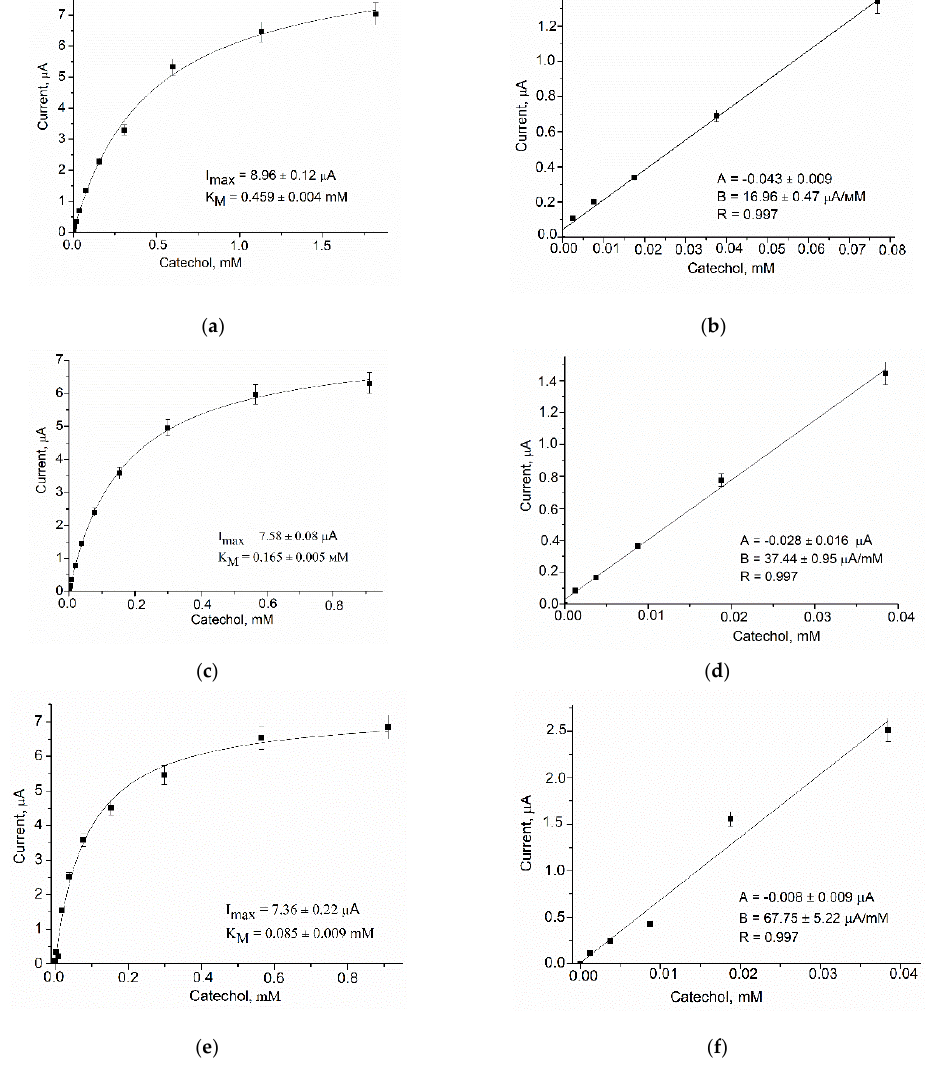
Figure 8. Amperometric characteristics of the laccase/GE ( a , b ), the laccase/nCuCe/GE ( c , d ), and the laccase/nCuCe/pAu/GE ( e , f ): ( a , c , e ) dependence of amperometric signal on concentration of catechol; ( b , d , f ) calibration graphs for catechol determination. Conditions: working potential –200 mV vs. Ag/AgCl/3 M KCl in 50 mM NaOAc, pH 4.5.